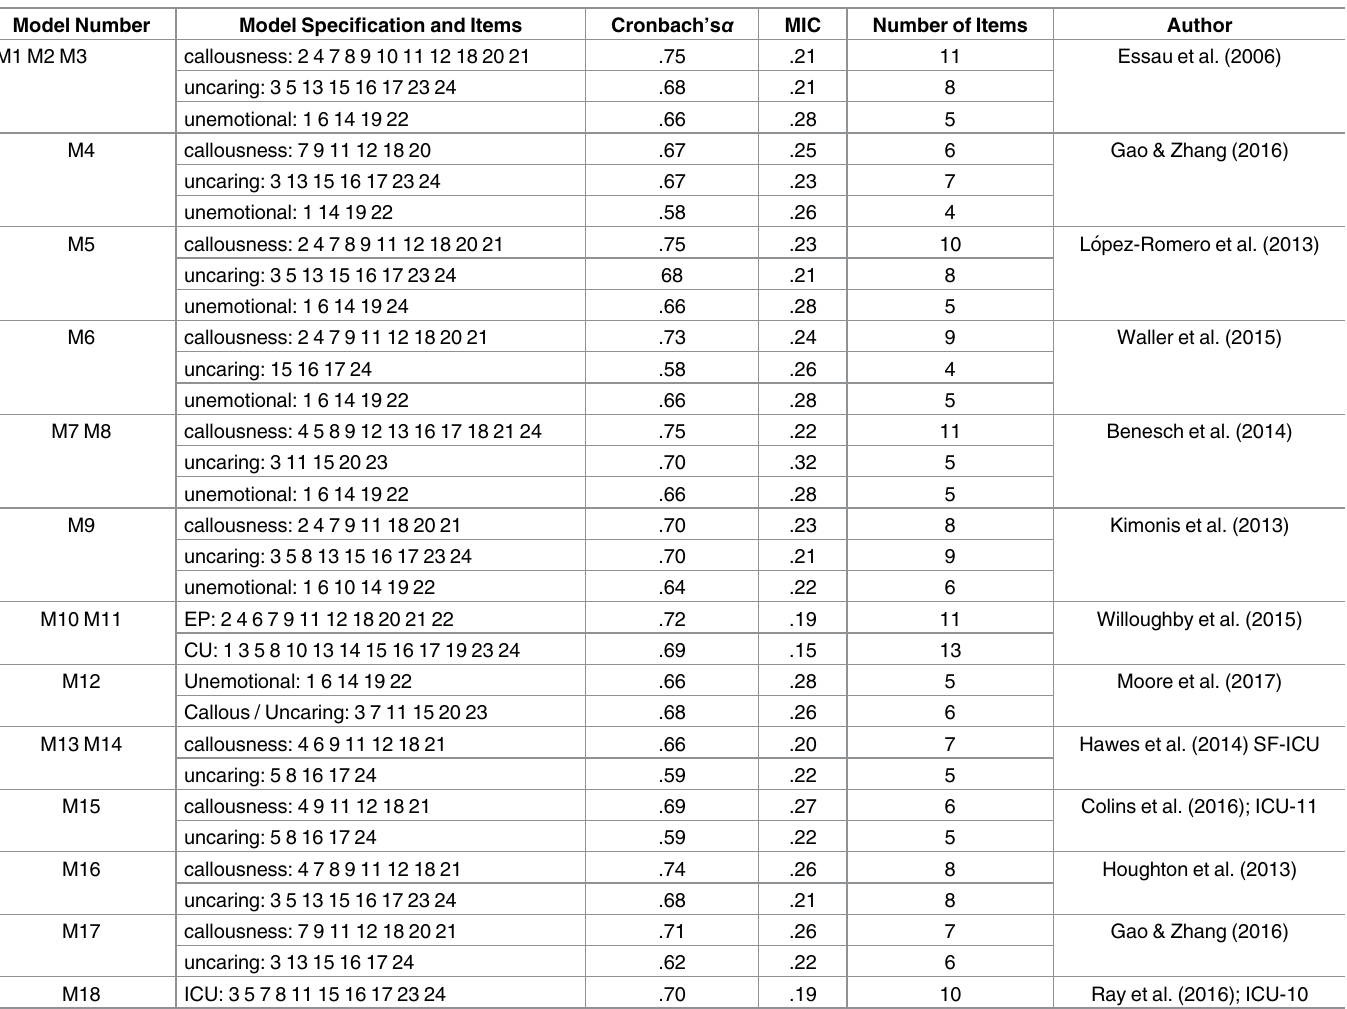
Table 2. Model specification for tested